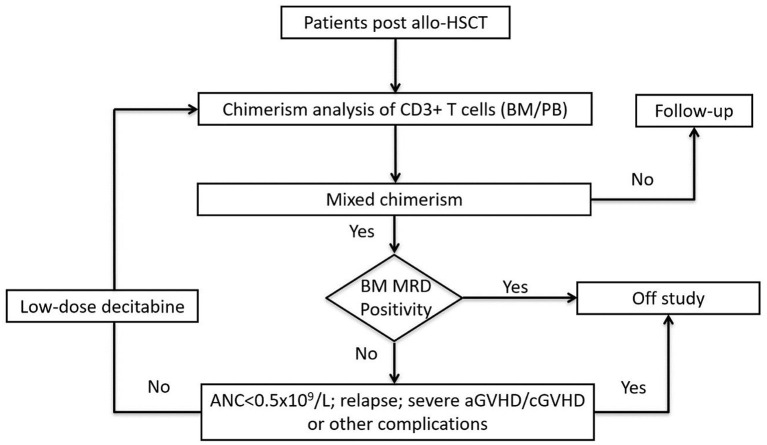
Flow chart of the study design.